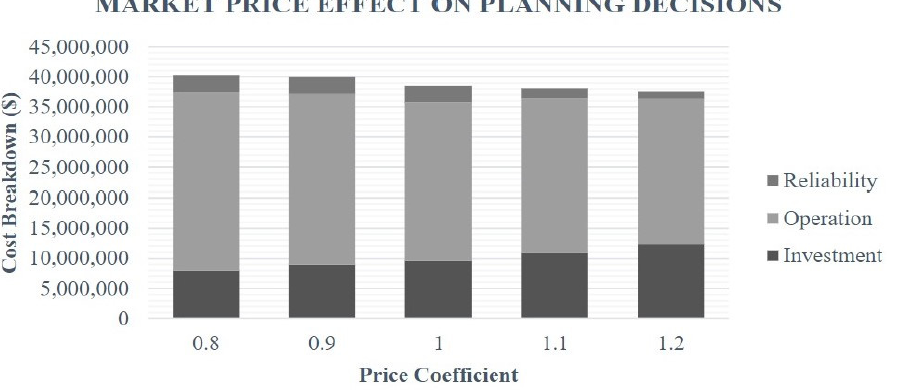
Figure 4. Market price effect on planning decisions.